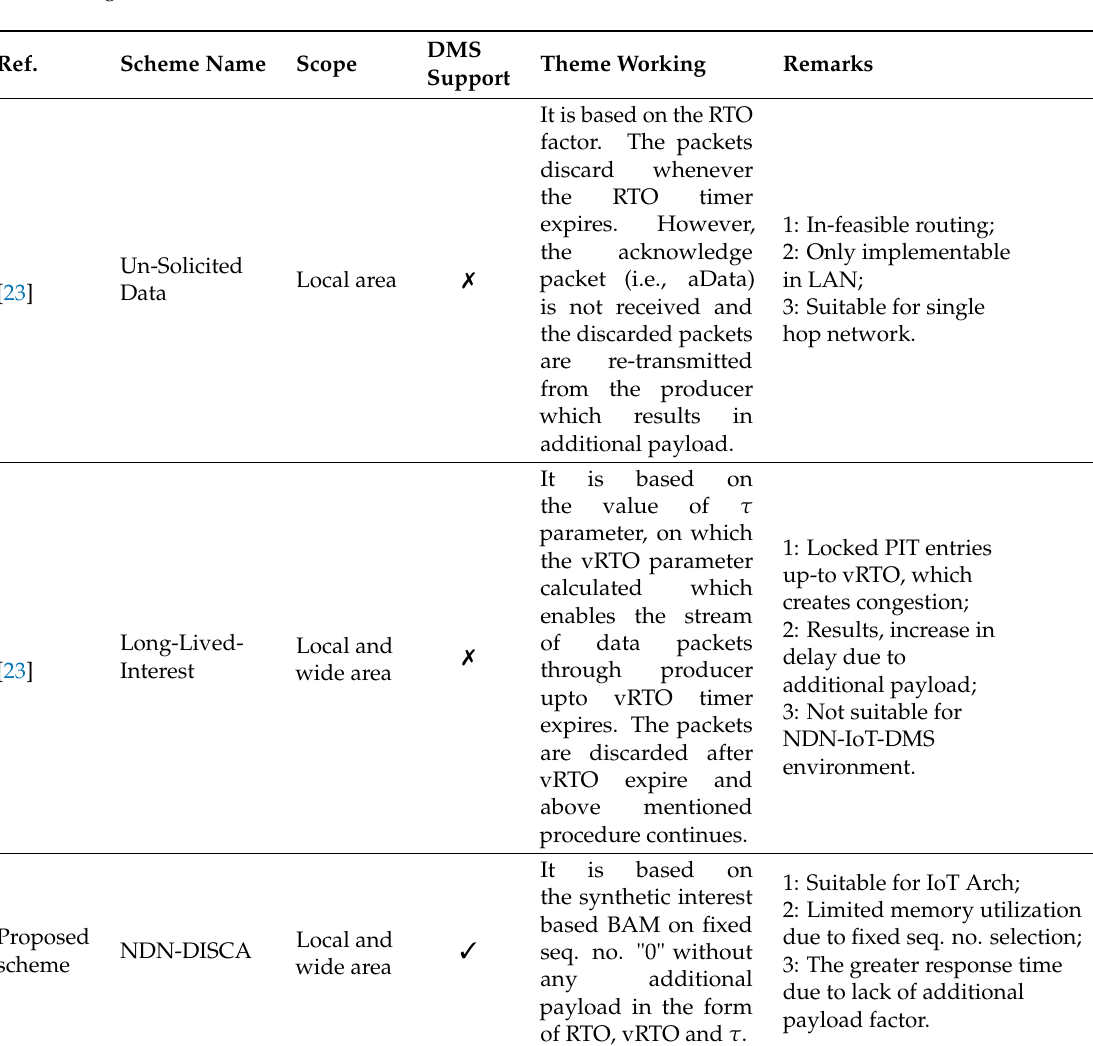
Table 4. Analytical Comparison b/w Proposed scheme NDN-DISCA and Existing Push Schemes (Un-solicited and Long-lived); RTO: Request Time Out, vRTO: Virtual Request Time Out, τ : Max. exchange info. b/w Consumer and